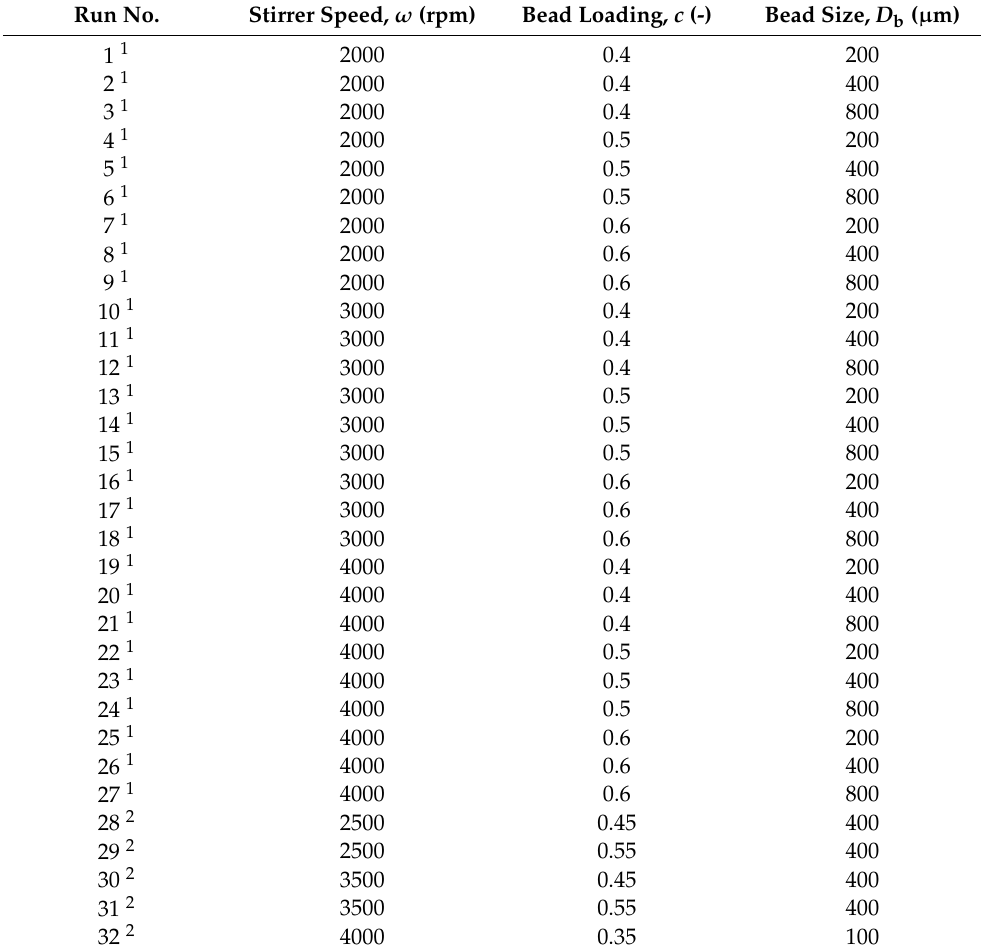
Table 1. Process parameters for the milling of FNB suspensions. Run No. Stirrer Speed, ω (rpm) Bead Loading, c (-) Bead Size, D b ( µ